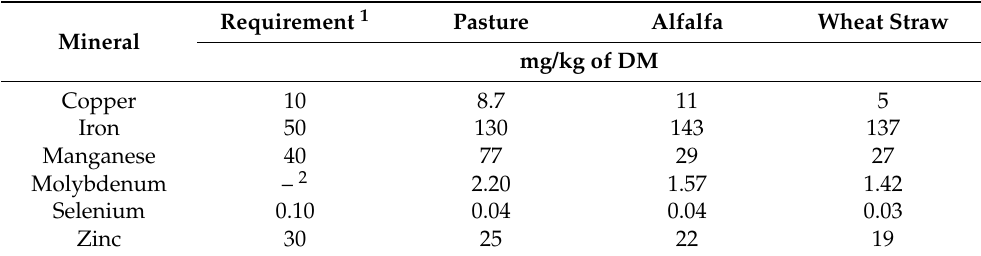
Table 1. Concentrations of trace minerals in orchard-grass-based pasture grazed from May to December and alfalfa hay and wheat straw fed to cows from December to May.